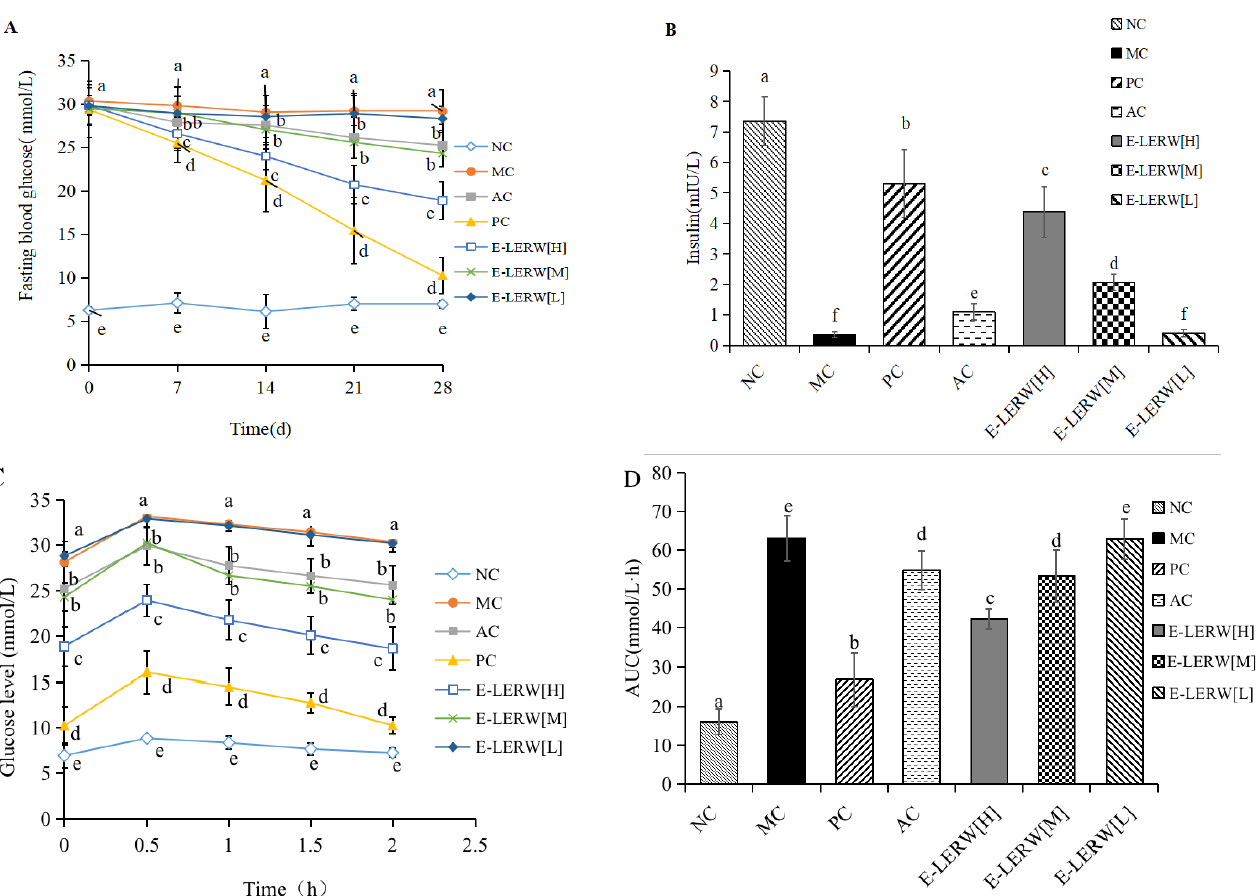
Figure 5. Effects of astilbin and E-LERW on the fasting blood glucose level ( A ), insulin secretion ( B ), oral glucose tolerance test ( C ), and AUC ( D ). All values were expressed as the mean ± SD ( n = 6). Data analysis was performed by one-way ANOVA and Duncan’s test. Different letters indicate significant differences among groups ( p < 0.05).